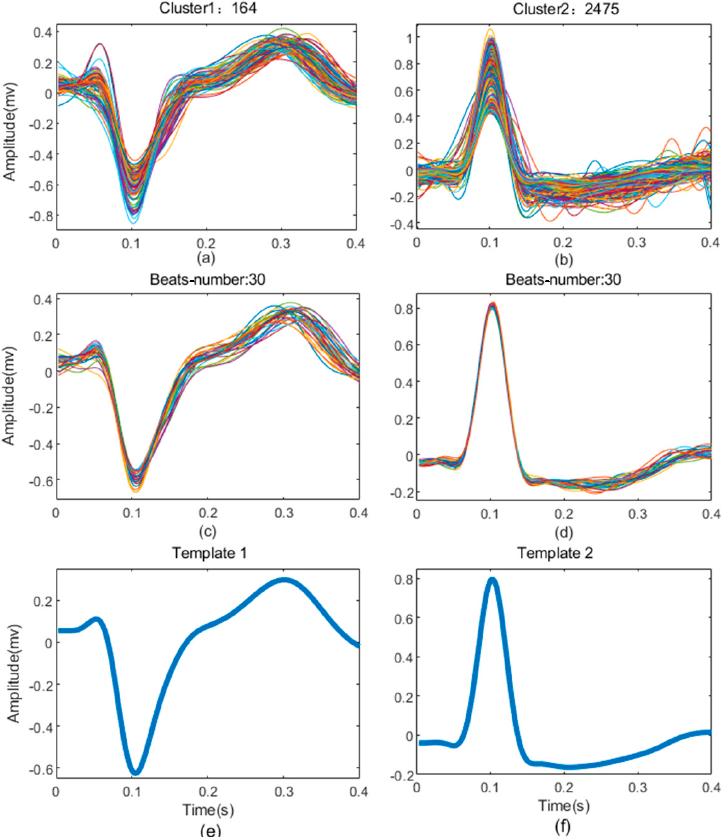
Figure 4. The results of clustering from record 210. ( a , b ) are all heartbeats superposition of each cluster; ( c , d ) are the 10 heartbeats extracted from each cluster to build templates; ( e , f ) are templates of the cluster.